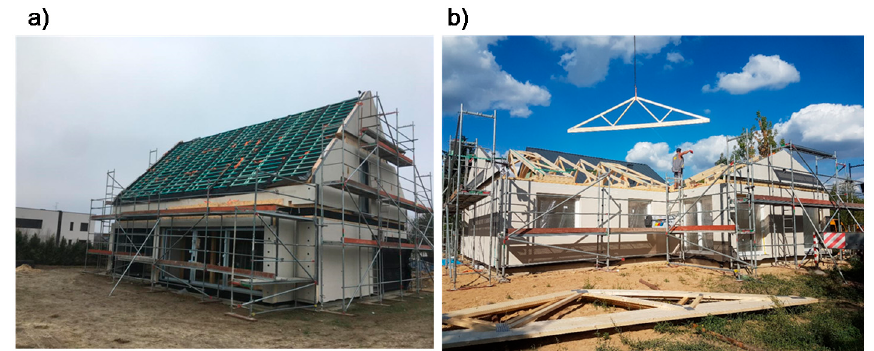
Figure 4. A residential building made in the technology of a prefabricated wooden skeleton with a prefabricated roof ( a ) purlin roof ( b ) roof truss (Silesia, Poland).